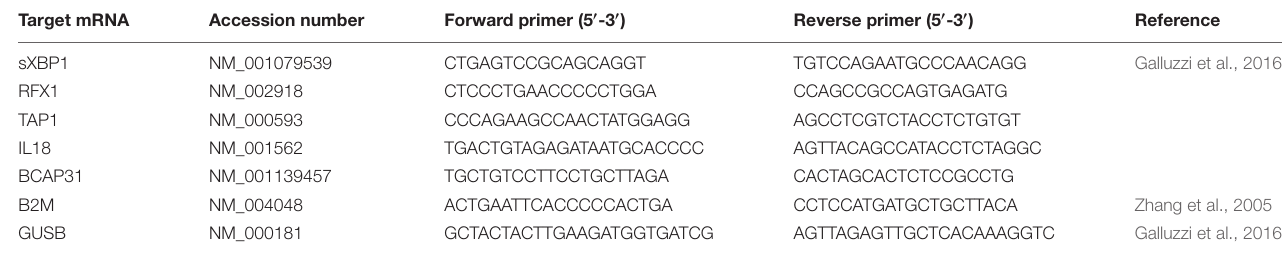
TABLE 1 | Primers used for gene expression analysis. Target